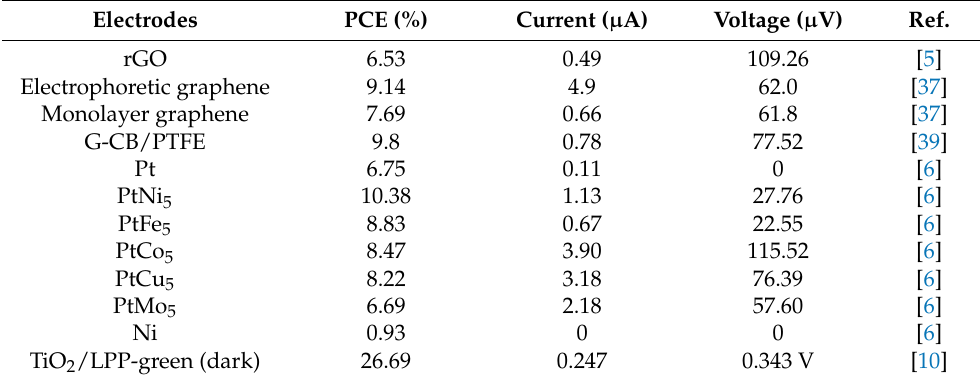
Table 6. The performance summary of rain-powdered all-weather solar cells.